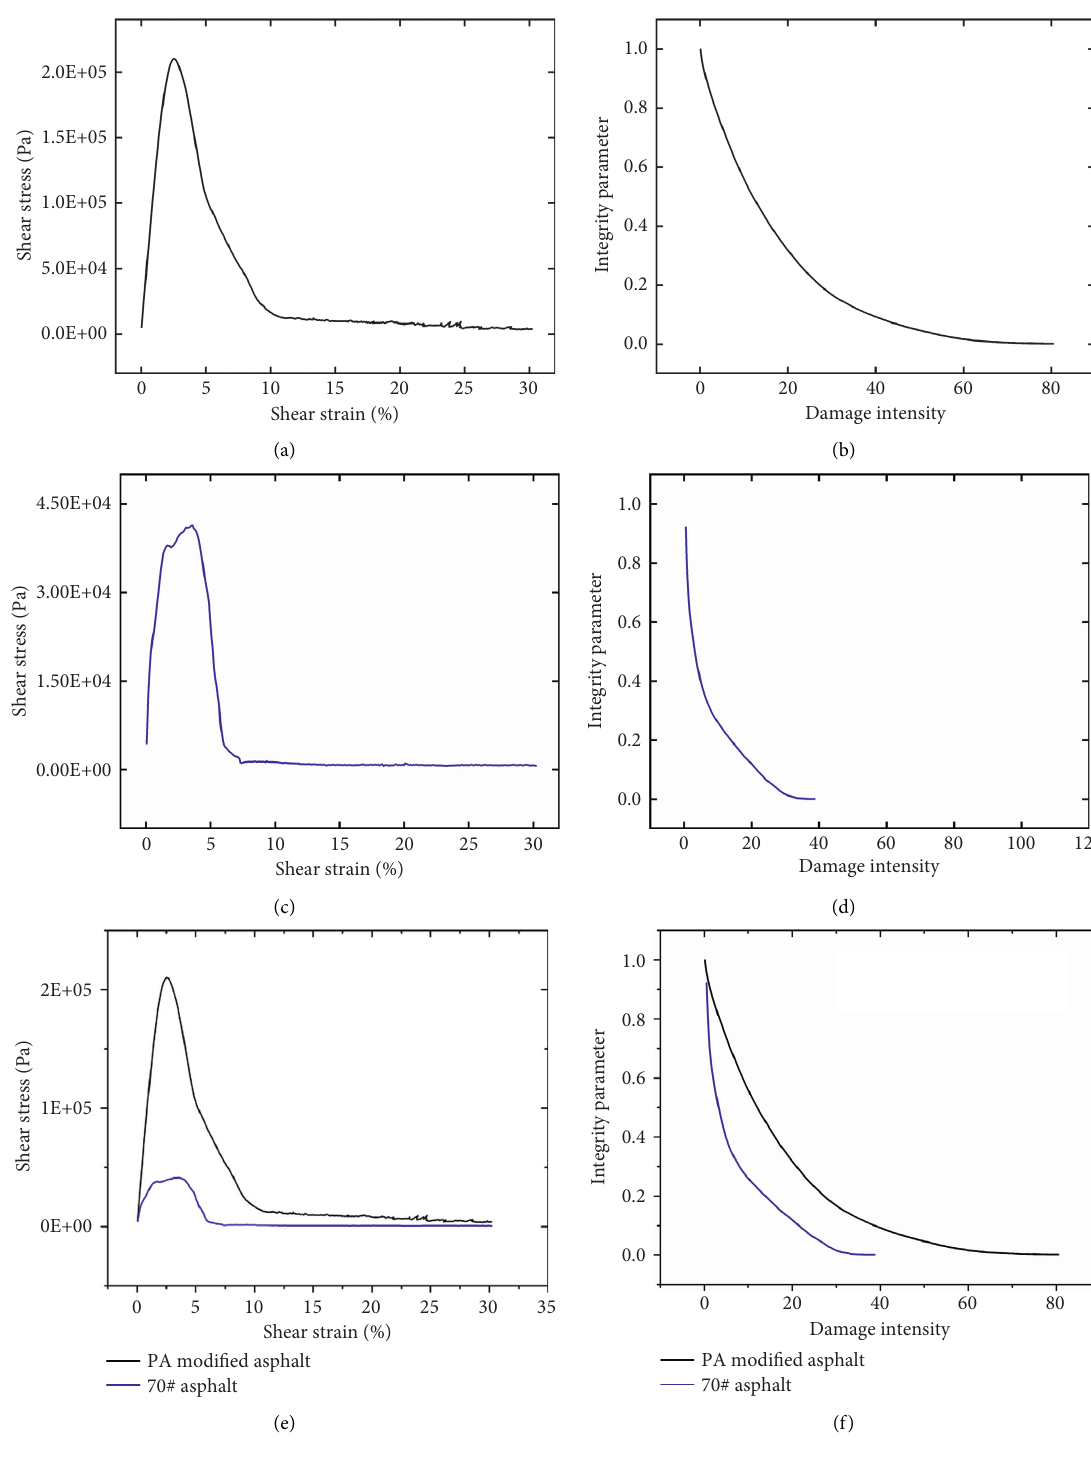
Figure 8: LAS analysis results of PA6-modified asphalt and 70#